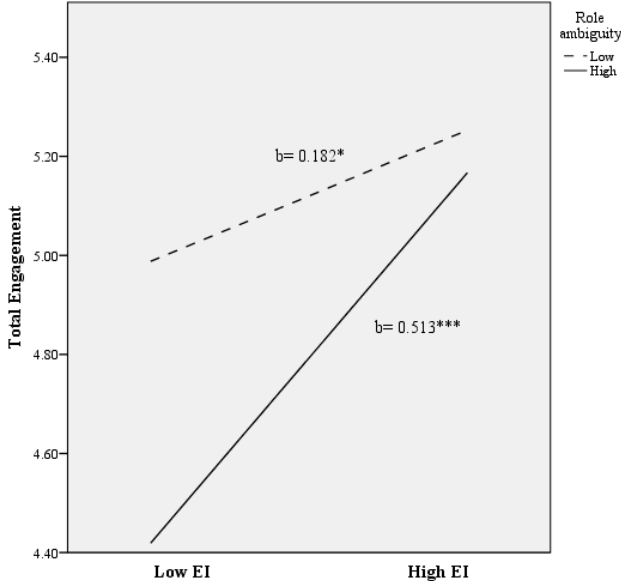
Figure 4. The relationship of emotional intelligence and role ambiguity for predicting total engagement scores. Note: EI = Emotional Intelligence. * p < 0.050; *** p <